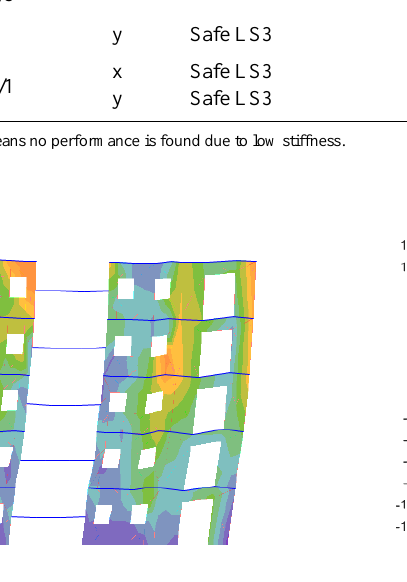
Figure 15. Ultimate level of shear stress distribution of TD-72/1 building obtained from pushover analysis (x- direction - kPa) Figure 16. Ultimate level of shear stress distribution of TD-72/1 building obtained from pushover analysis (y- direction - kPa)